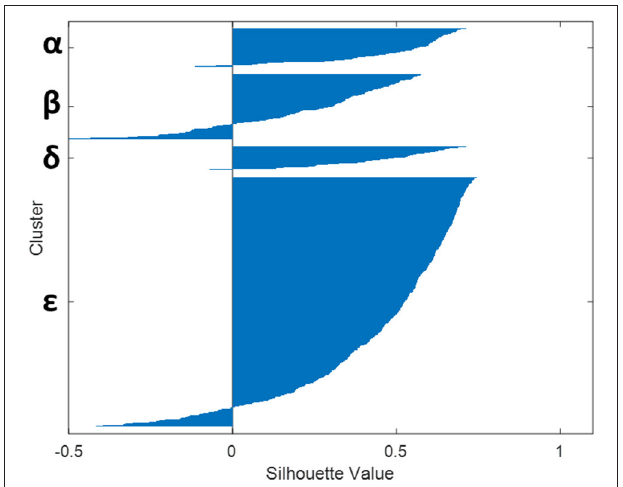
FIGURE 4 | Relevance of the four clusters ( α , β , δ , and ε ) obtained as assessed by the observation of the Silhouette coefficient on the records.